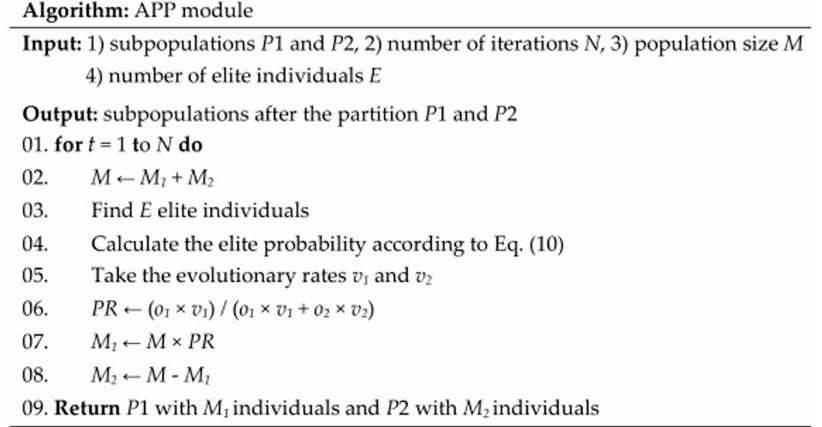
Figure 7. Pseudocode of APP